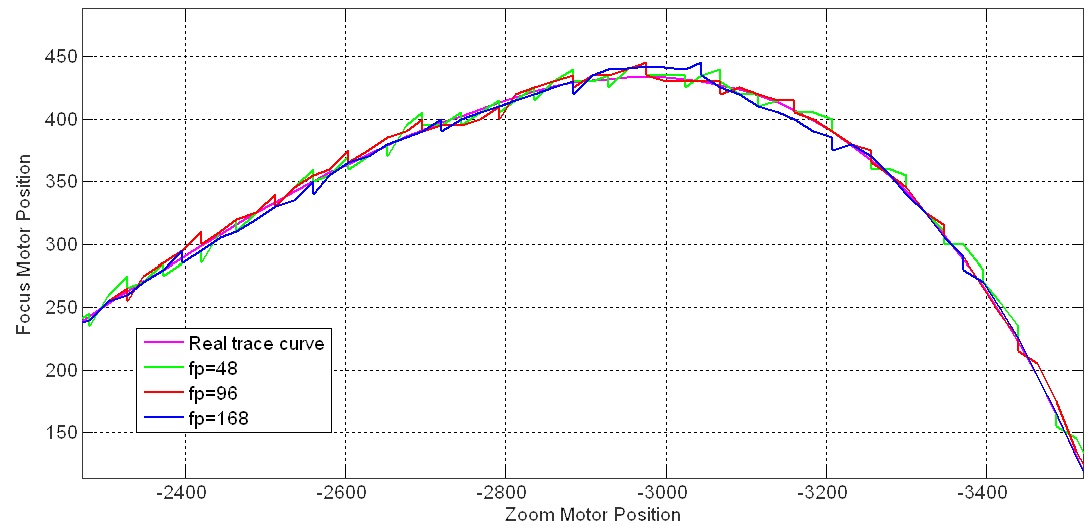
Figure 19. Trace curves for different FZT feedback periods.